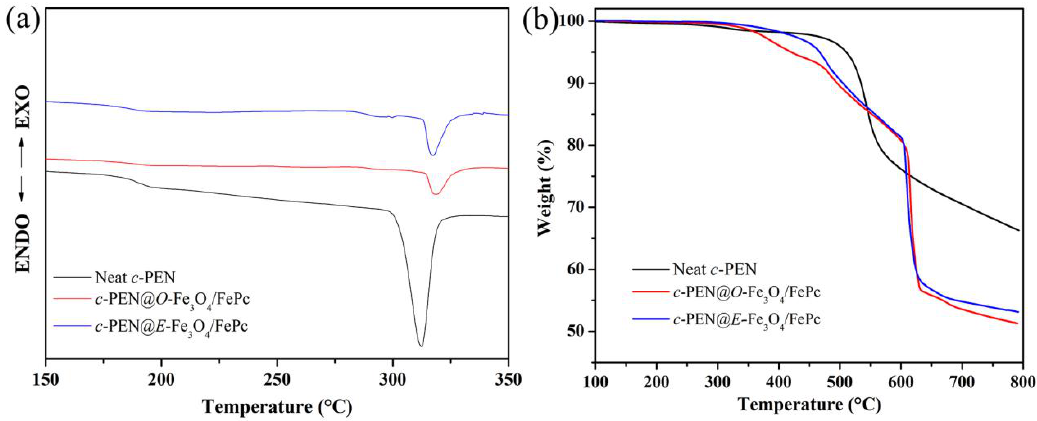
Figure 6. ( a ) DSC and ( b ) TGA curves of neat c -PEN, c -PEN@ E -Fe 3 O 4 /FePc, and c -PEN@ O -Fe 3 O 4 /FePc after 4 h of heat treatment at 280 °C. Table 1. The glass transition temperature ( T g ), melt enthalpy (Δ H ), and initial decomposition